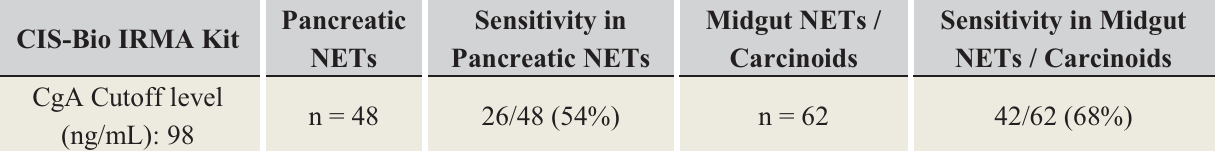
Table 2. CgA sensitivities (number of patients with median CgA values above reference range/number of all patients of the corresponding group) depending on tumor primary.